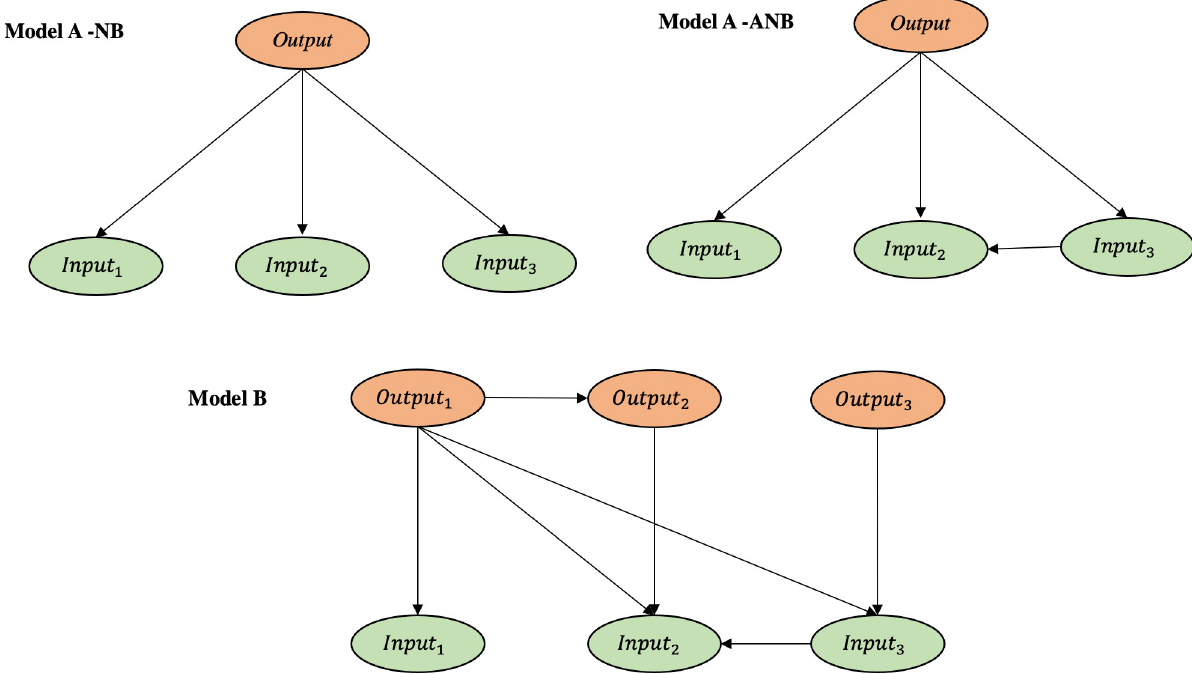
Fig 4. Examples of the structures of the three types of BNs in Table 3. Outputs (orange) and inputs (green).